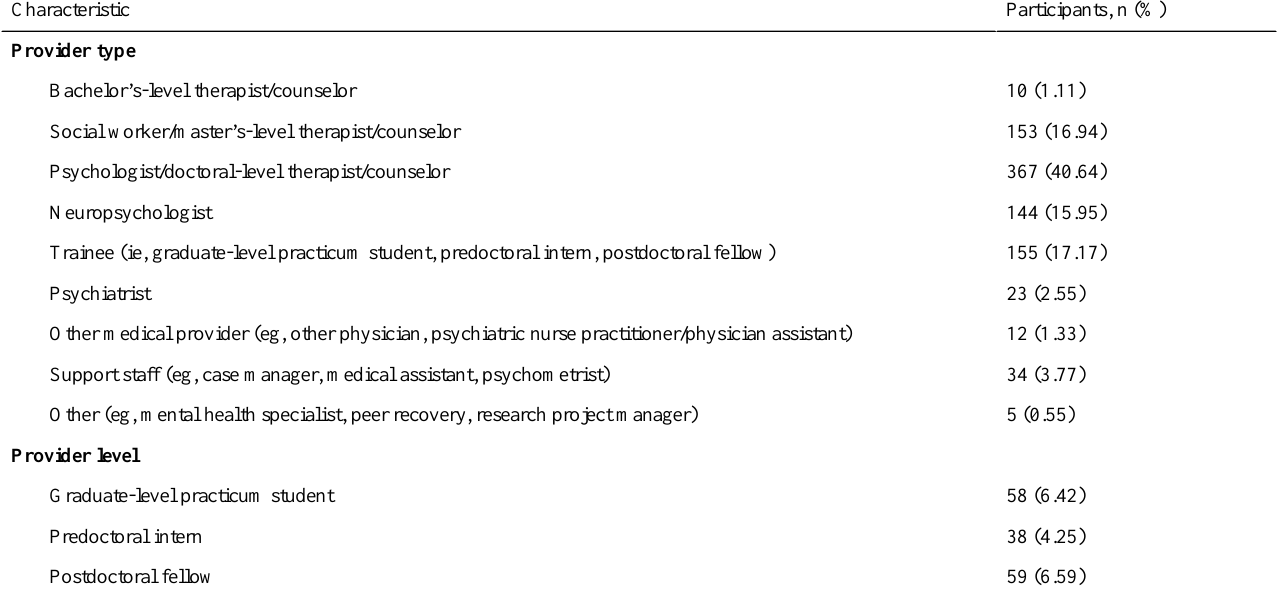
Table 2. Professional characteristics of the full sample (N=903).